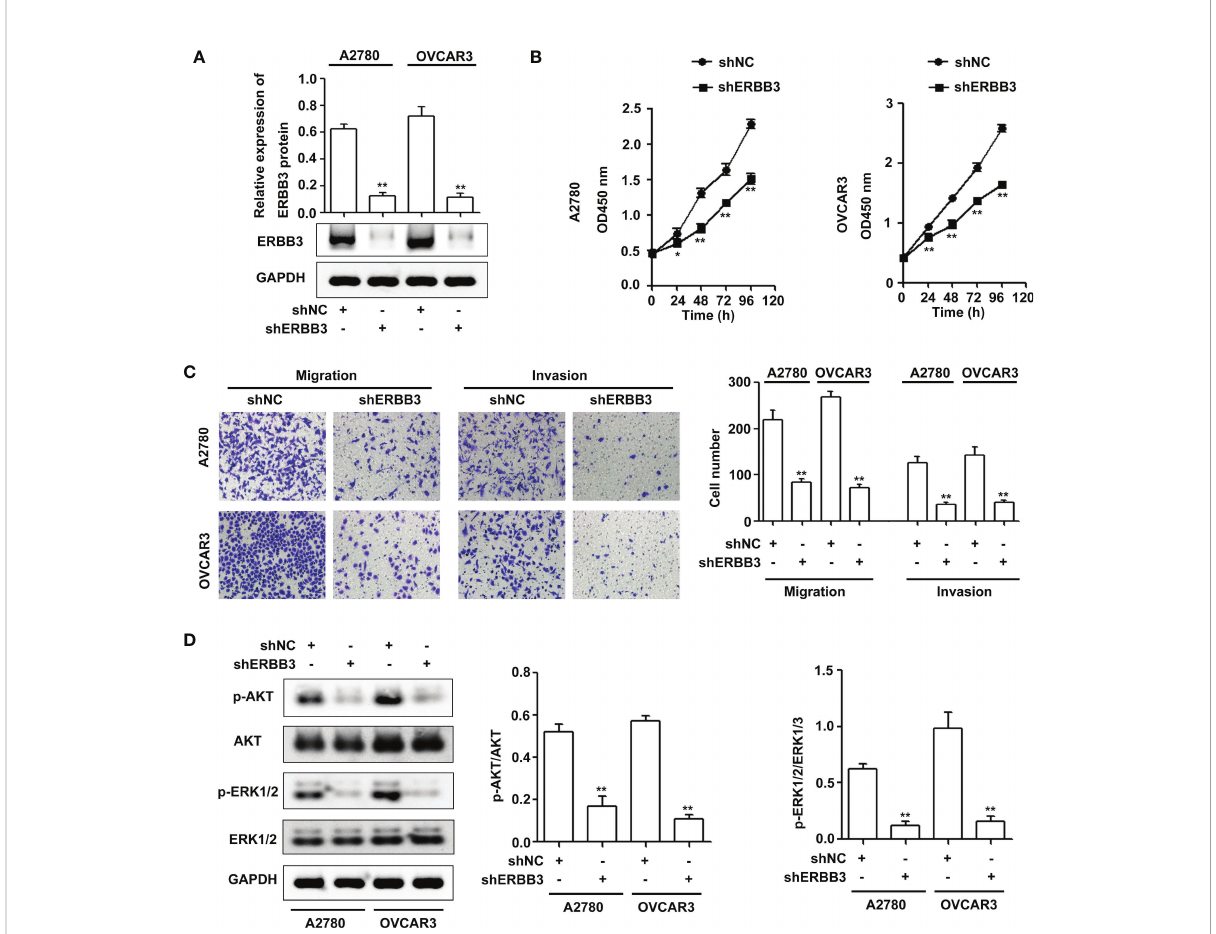
FIGURE 5 ERBB3 downregulation inhibits EOC progression via the PI3K-AKT and MAPK signaling axes. (A) NUF2 expression in A2780 and OVCAR3 cells after transfection with shNC and shERBB3 was detected by western blot. ** P < 0.01 vs. the shNC group. (B) A CCK-8 assay was used to determine the viability of A2780 and OVCAR3 cells after transfection with shNC and shERBB3. * P < 0.05, ** P < 0.01 vs. the shNC group. (C) Transwell assays were used to determine the migration and invasion of A2780 and OVCAR3 cells after transfection with shNC and shERBB3 (original magni fi cation, × 200). ** P < 0.01 vs. the shNC group. (D) Effects of ERBB3 silencing on the phosphorylation of AKT and ERK1/2. GAPDH was used as an internal control. ** P < 0.01 vs. the shNC